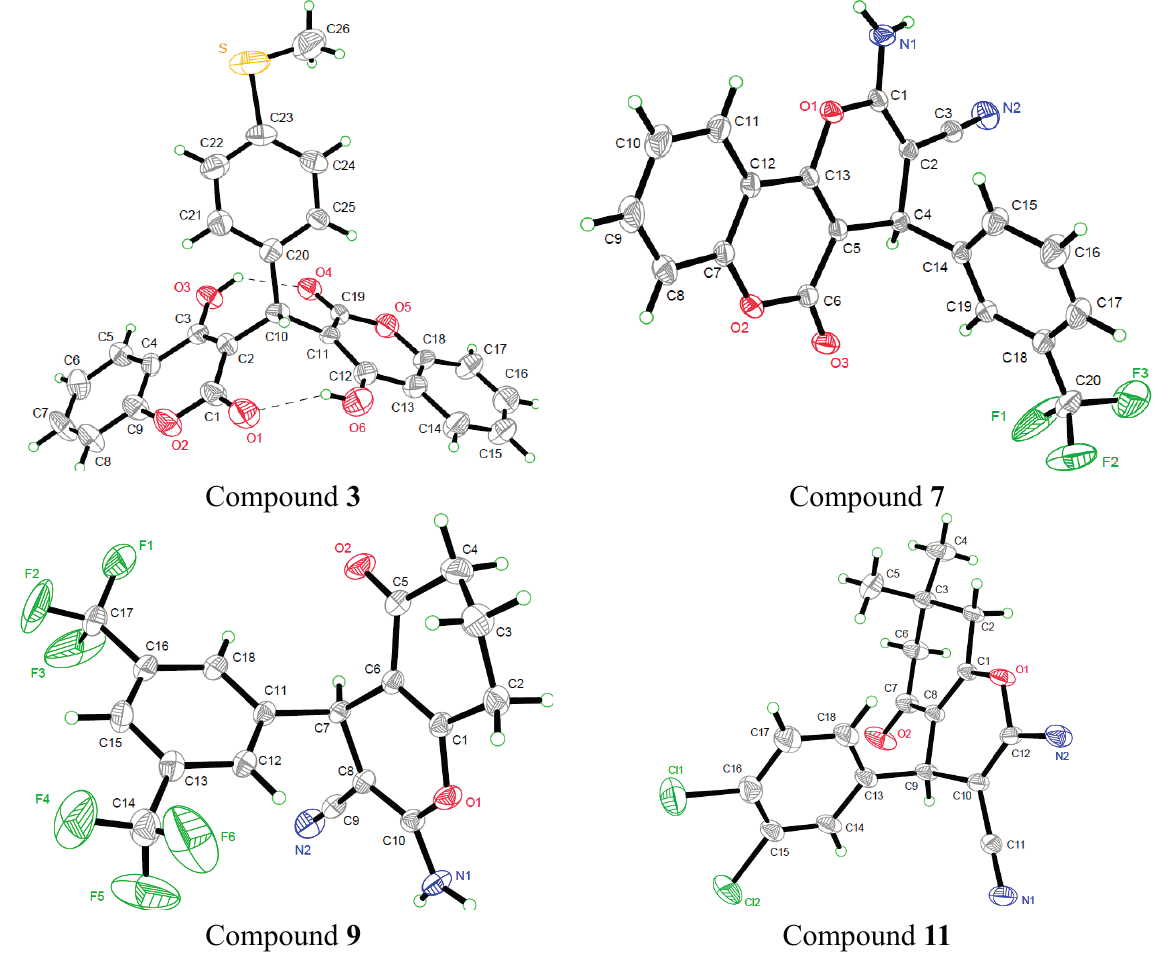
Figure 2. Crystal structures of compounds 3 , 7 , 9 and 11